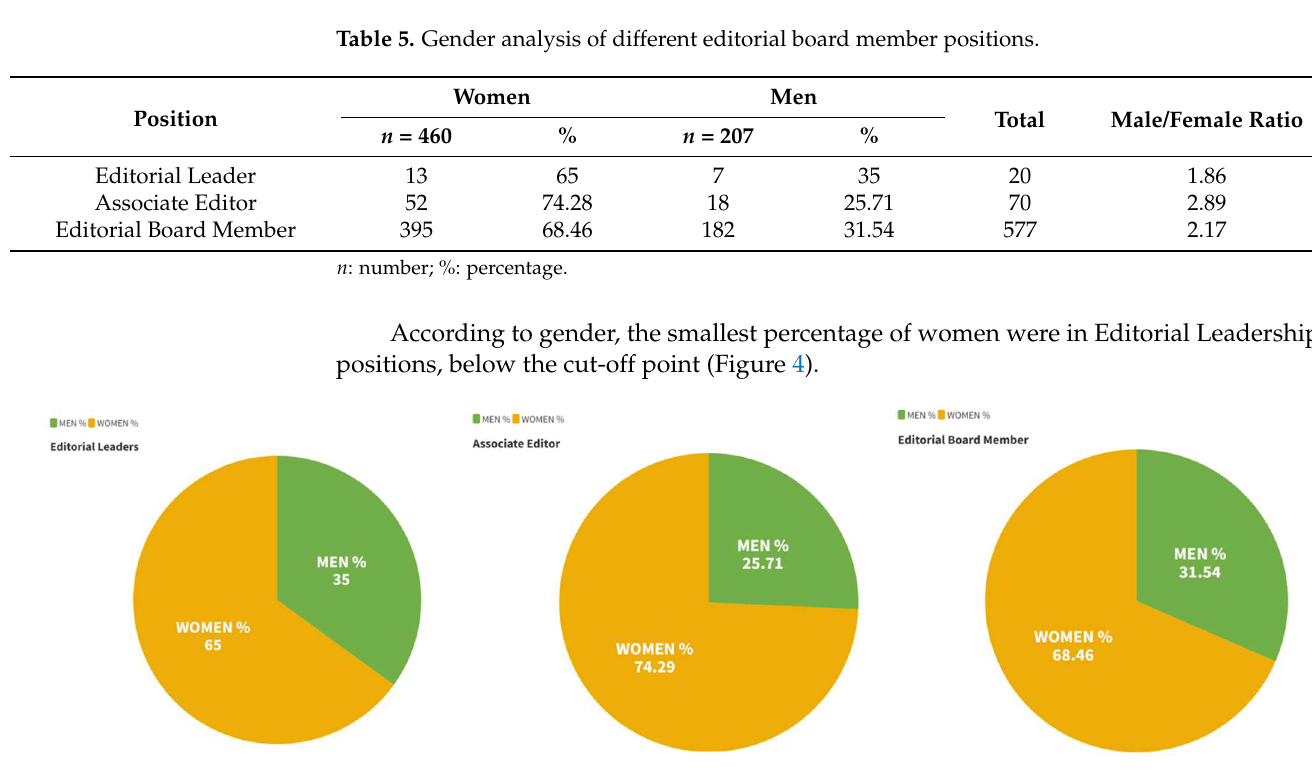
Figure 4. Composition of the editorial board according to gender.